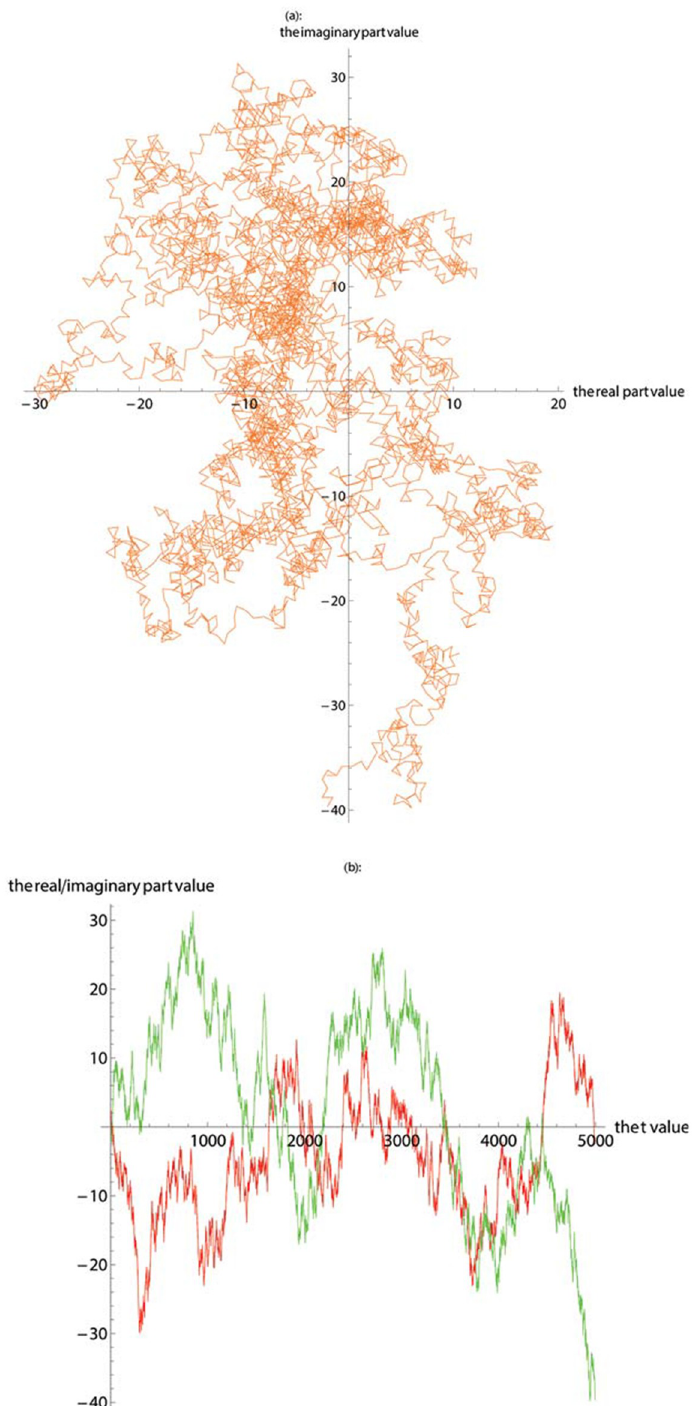
Fig 2. The TP walk of the randomly generated base sequence. ( a ) Plot the walk trace in the complex plane. ( b ) Plot the real part (red) and imaginary part (green).